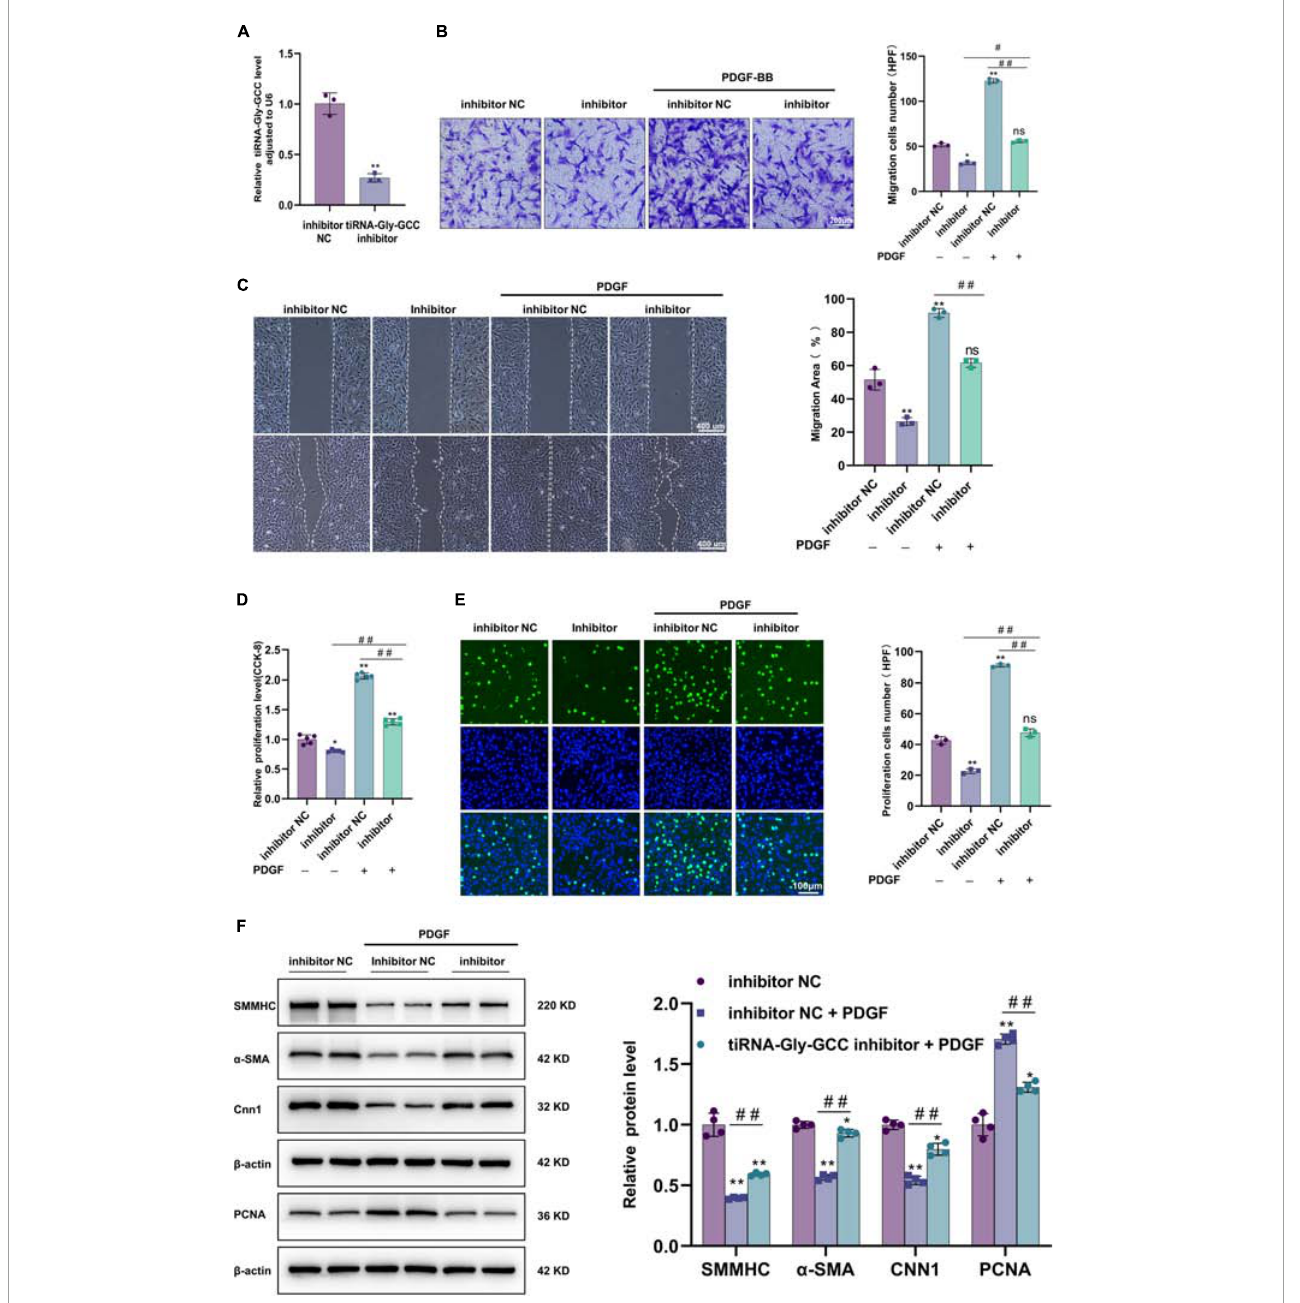
FIGURE5 Inhibition of tiRNA-Gly-GCC suppressed HASMCs proliferation and migration and reversed the HASMCs dedifferentiation induced by PDGF-BB. (A) qRT-PCR confirmed the inhibition efficiency of the tiRNA-Gly-GCC inhibitor compared to inhibition negative control (inhibition NC) in HASMCs, normalized to U6. Data are presented as the mean ± SD. n = 3, **p < 0.01. (B) The left panel refers to representative image of Transwell assays and the right panel refers to quantification results of migrated HASMCs, from three independent experiments. HASMCs were transfected with inhibitor NC or tiRNA-Gly-GCC inhibitor then treated with PDGF-BB (50 ng/ml) or not. Data are presented as the mean ± SD. n = 3, *p < 0.05, **p < 0.01, ns: not significant (versus inhibitor NC). # p < 0.05, ## p < 0.01 compared with the two groups, which are labeled by a horizontal line. (C) The left panel refers to representative image of wound healing assays and the right panel refers to quantification results of migration area, from three independent experiments. Scale bar, 400 µ m. HASMCs were transfected with inhibitor NC or tiRNA-Gly-GCC inhibitor then treated with PDGF-BB (50 ng/ml) or not. Data are presented as the mean ± SD. n = 3, **p < 0.01, ns: not significant (versus inhibitor NC). # p < 0.05, ## p < 0.01 compared with the two groups, which are labeled by a horizontal line. (D) CCK-8 assays indicated that the inhibition of tiRNA-Gly-GCC reduced the proliferation of HASMCs treated or not with PDGF-BB (50 ng/ml). Data are presented as the mean ± SD. n = 5, *p < 0.05, **p < 0.01 (versus inhibitor NC). ## p < 0.01 compared with the two groups, which are labeled by a horizontal line. (E) The left panel refers to representative image of EdU assays and the right panel refers to quantification results of migrating cells, from three independent experiments. HASMCs were transfected with inhibitor NC or tiRNA-Gly-GCC inhibitor then treated with PDGF-BB (50 ng/ml) or not. Data are presented as the mean ± SD. n = 3, **p < 0.01, ns: not significant (versus inhibitor NC). ## p < 0.01 compared with the two groups, which are labeled by a horizontal line. (F) The left panel refers to representative image of Western blot analysis for the expression of SMMHC, α -SMA, CNN1, and PCNA on HASMCs transfected with inhibitor NC or tiRNA-Gly-GCC inhibitor then treated with PDGF-BB or not (50 ng/ml). The right panel refers to densitometric quantification of these proteins expression normalized by β -actin, from three independent experiments. Data are presented as the mean ± SD. n = 3, *p < 0.05, **p < 0.01 (versus inhibitor NC). ## p < 0.01 compared with the two groups, which are labeled by a horizontal